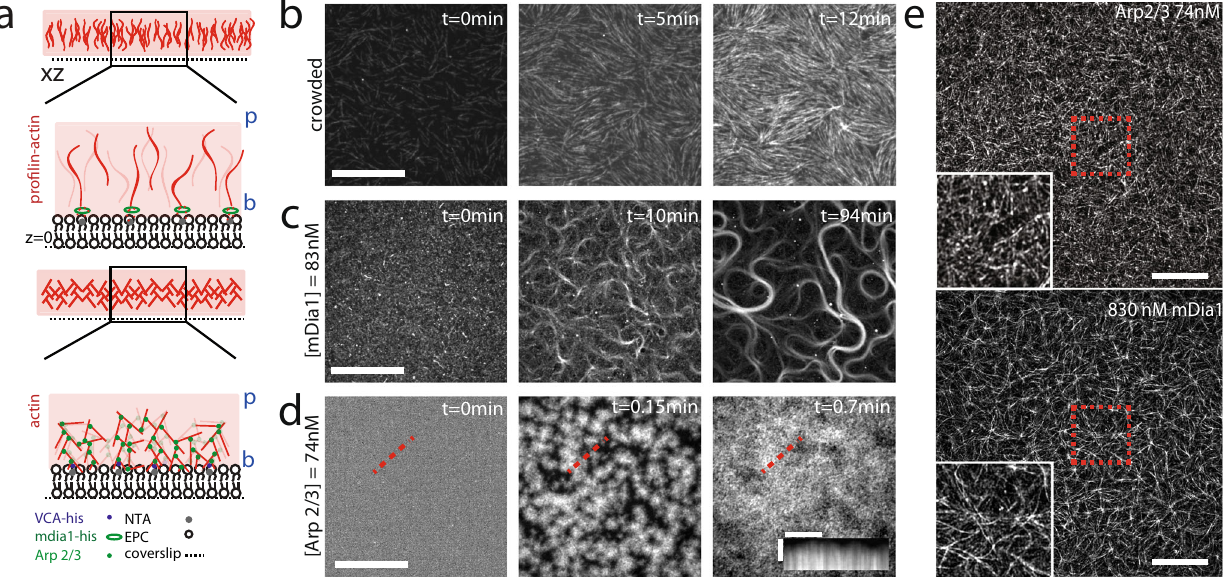
Fig. 1 | Reconstitution of F-actin networks with variable architectures. a Diagram of F-actin nucleated and grown from a phospholipid bilayer with either mDia1 (green ellipses) coupled to nickel lipid (NTA) (top) or Arp2/3 (green dots) activated by VCA (blue dots) coupled to nickel lipid (bottom). ( ‘ b ’ is barbed end, and ‘ p ’ is pointed end of F-actin. b Pre-polymerized F-actin crowded to the surface ofthebilayerovertime.Scalebaris20 μ m. c 83nMmDia1-nucleatedF-actingrowth